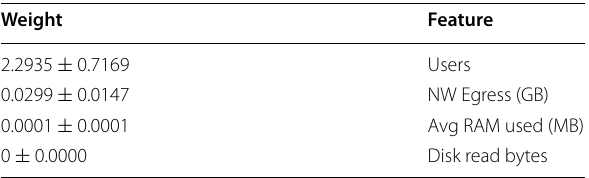
Table 8 Permutation importance feature rank for QoS model